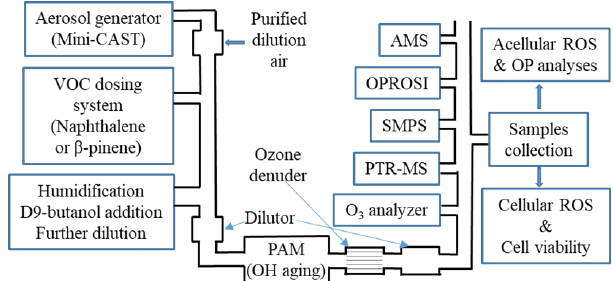
Figure 1. A schematic of the experimental setup for SOA genera- tion and characterization. SOA was generated from naphthalene and β -pinene condensed on soot particles (SP) from a miniature com- bustion aerosol standard (mini-CAST) soot generator under varied atmospheric conditions (UV lamp intensity and humidity). Sev- eral online instruments were used for a comprehensive gas- and particle-phase characterization (including the online ROS instru- ment OPROSI). Filter samples were collected for various chemical and biological offline